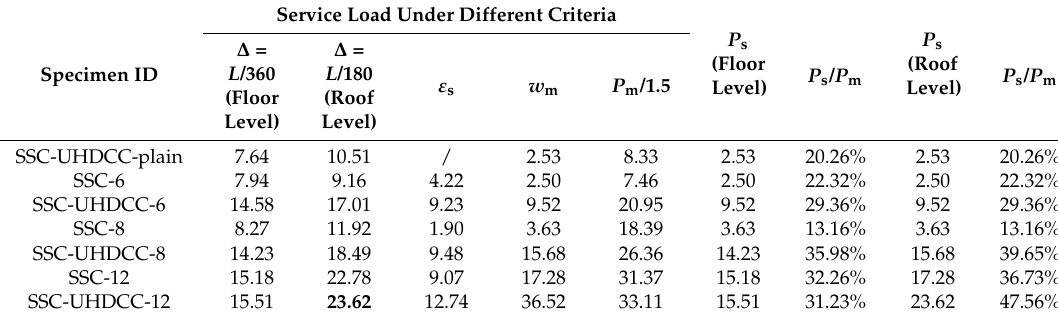
Table 6. Service load using various criteria (kN).